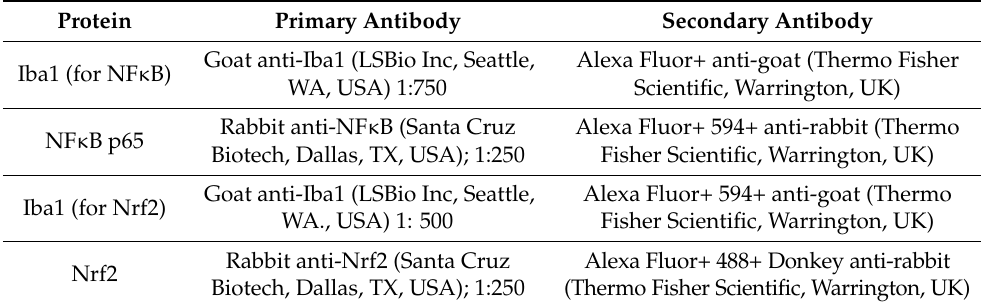
Table 1. Antibodies used in